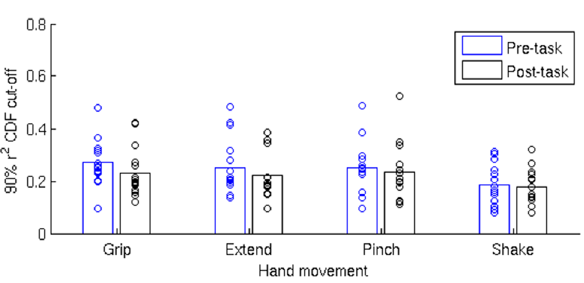
Figure 5. A comparison between the similarity of each task-defined pattern and the pre- and post-task rest spontaneous patterns. In the Grip and the Extend condition there was a trend indicating a reduction in the overall observed similarity in the post-task rest relative to the pre-task rest. No such reduction was observed for the Pinch and Shake